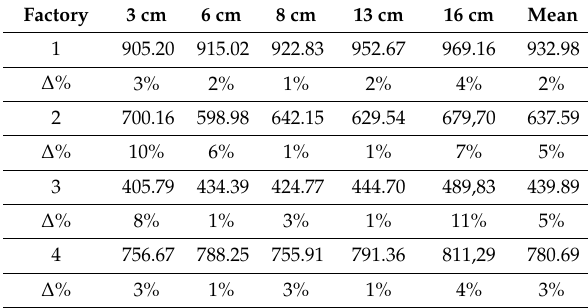
Table 8. Dry density—intensive samples.